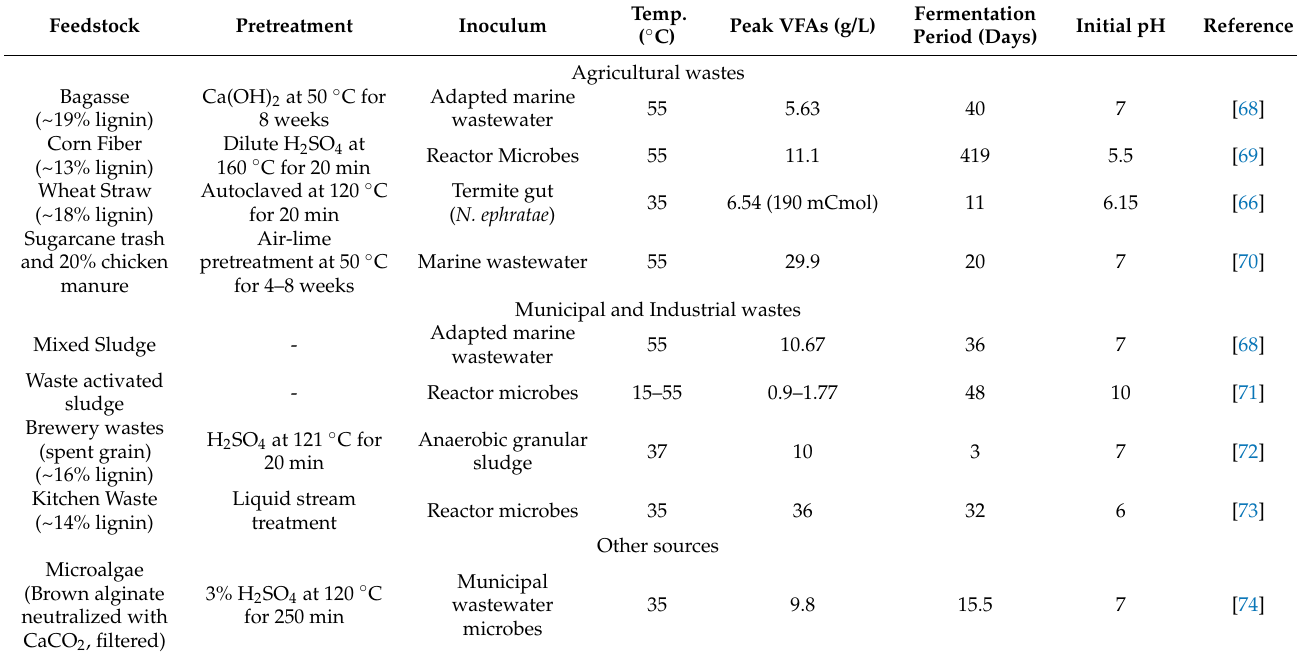
Table 3. Summary of typical feedstock types, inoculum and operation parameters used for VFA